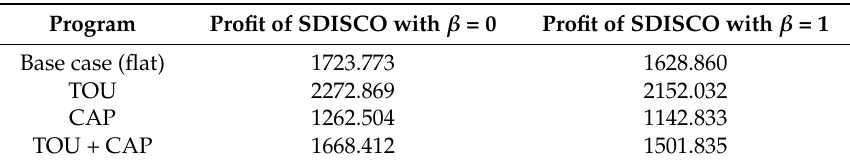
Table 6. The profit of different DR programs in β = 0, 1.